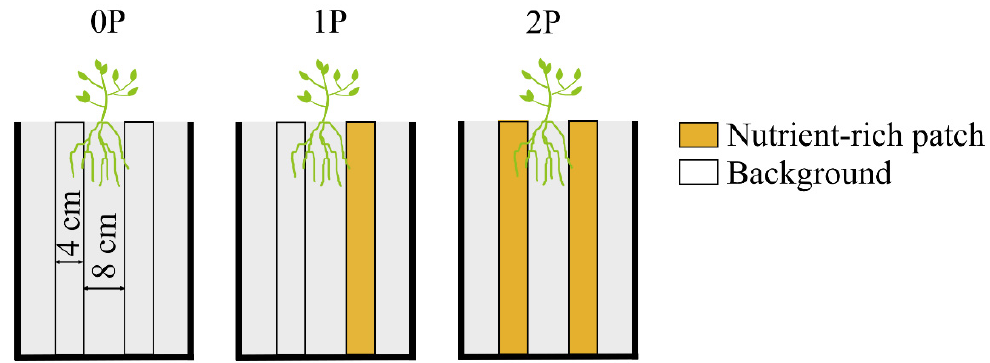
Figure 7. Schematic of heterogeneous nutrient treatments.